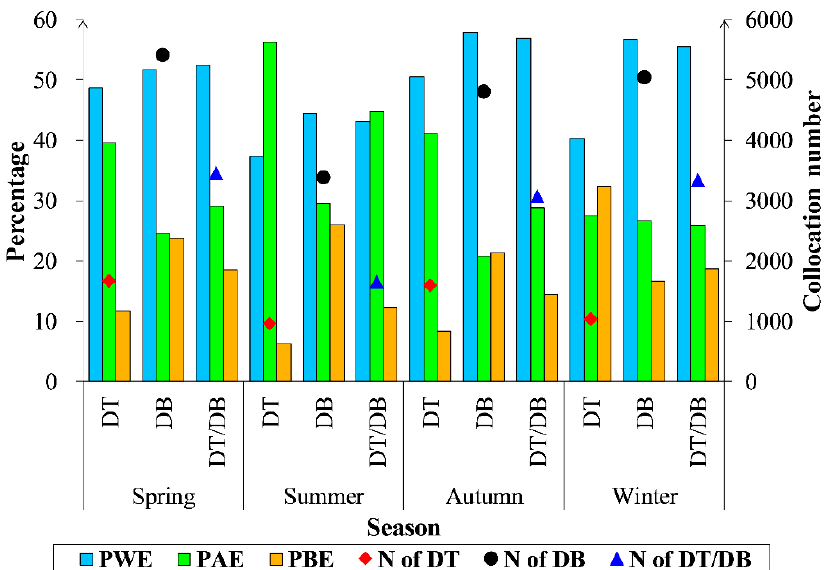
Figure 4. The percentage within in (PWE), above (PAE) and below (PBE) the expected error and the number of collocations for the DT, DB and DT/DB products in the four seasons over heavy aerosol loading area for the years 2000–2016.